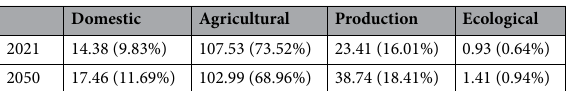
Table 4. Forecast of water demand in 2021 and 2050 (10 8 m 3